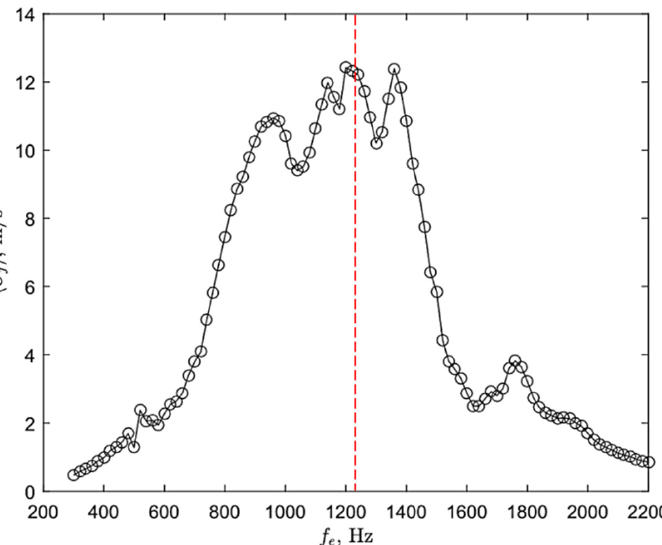
Figure 4. Time–mean velocity, (cid:104) U j (cid:105) , at the centre of the jet exit plane (X/D = Y/D = 0) as a function of the excitation frequency, f e , for the unified array cavity at the exit of the orifice located in the middle of the array (n = 8), E = 150 V pp . Estimated Helmholtz frequency value is shown by dotted line.